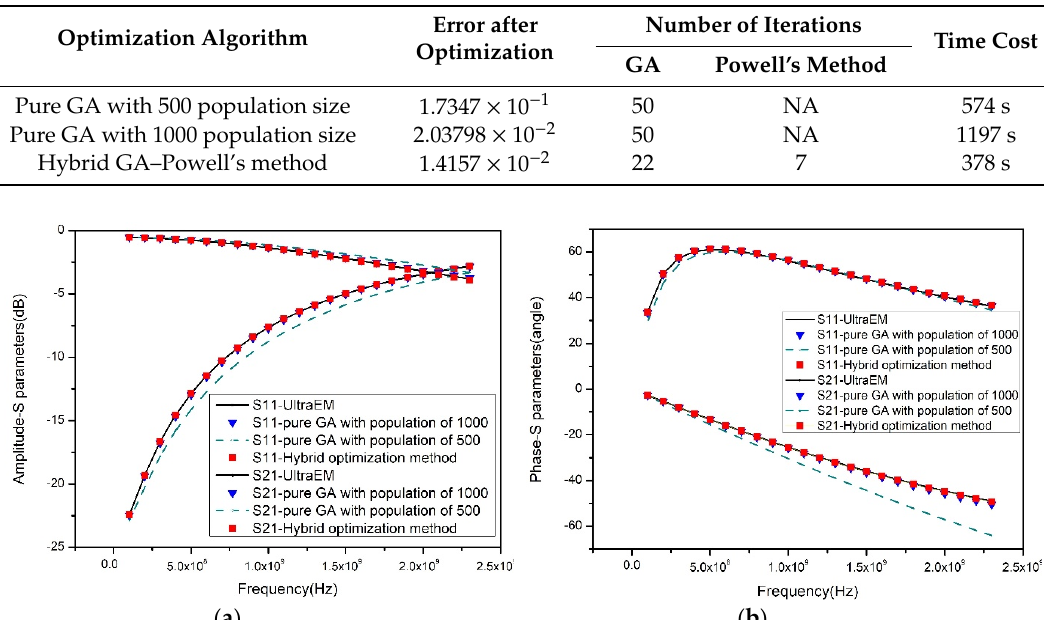
Figure 5. Error of objective function of the planar spiral inductor. Solid line represents the error of Hybrid GA–Powell’s method. Dash-dot line represents error of pure GA with population of 500. Dash line represents error of pure GA with population of 1000. Table 2. Error after optimization and time cost of optimization algorithm with the example of planar spiral inductor.